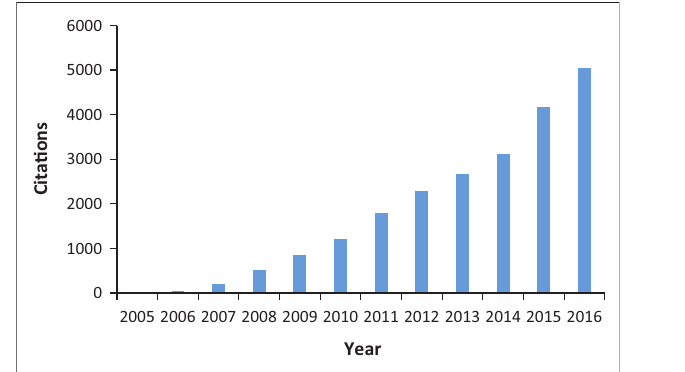
FIGURE 2: Number of citations about organisational culture for each year from 2005 to 2016 in the Web of Science.